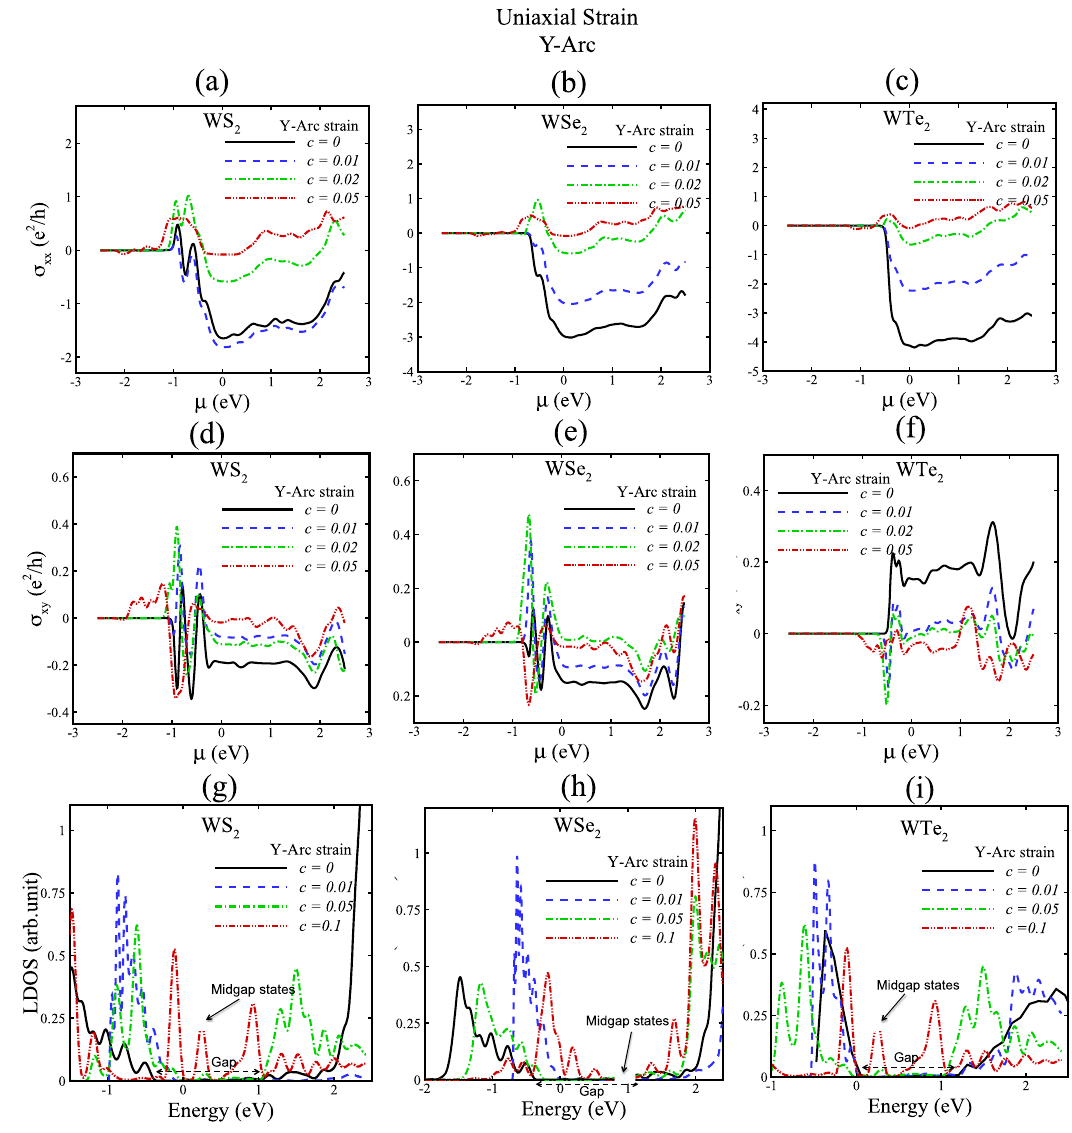
Figure 8. Hall conductivity and local density of states (LDOS) of WX 2 (X = S, Se, Te) for uniaxial Y-arc strain with c = 0, 0.01, 0.02, 0.05, 0.1. In ( g ), ( h ) and ( i ) gap and midgap states are